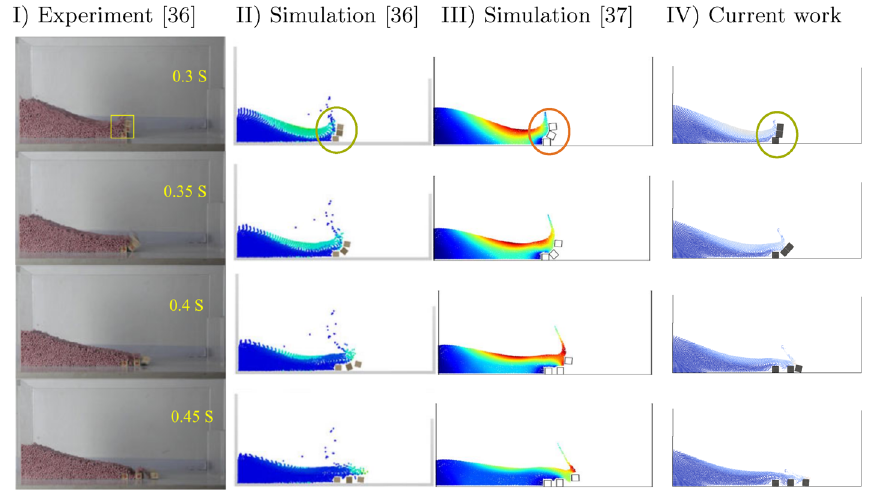
Fig. 12 Comparison of the experimental results [36] and the numerical solutions obtained by [36], [37] and our simulation results during the impact